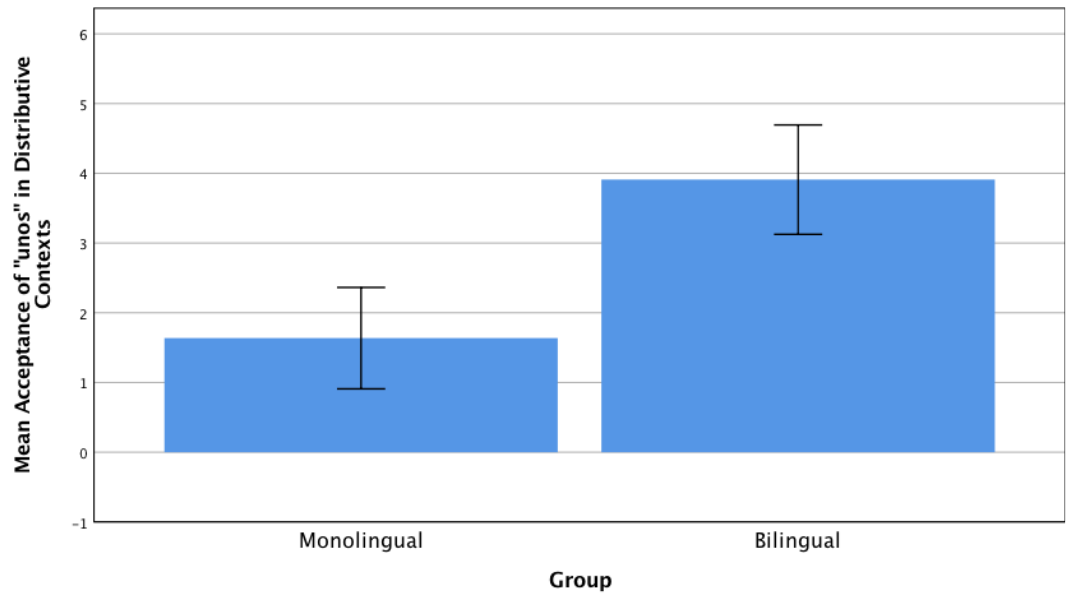
Figure 9. Mean Acceptance of Unos ‘Some’ Collective Sentences in Distributive Contexts